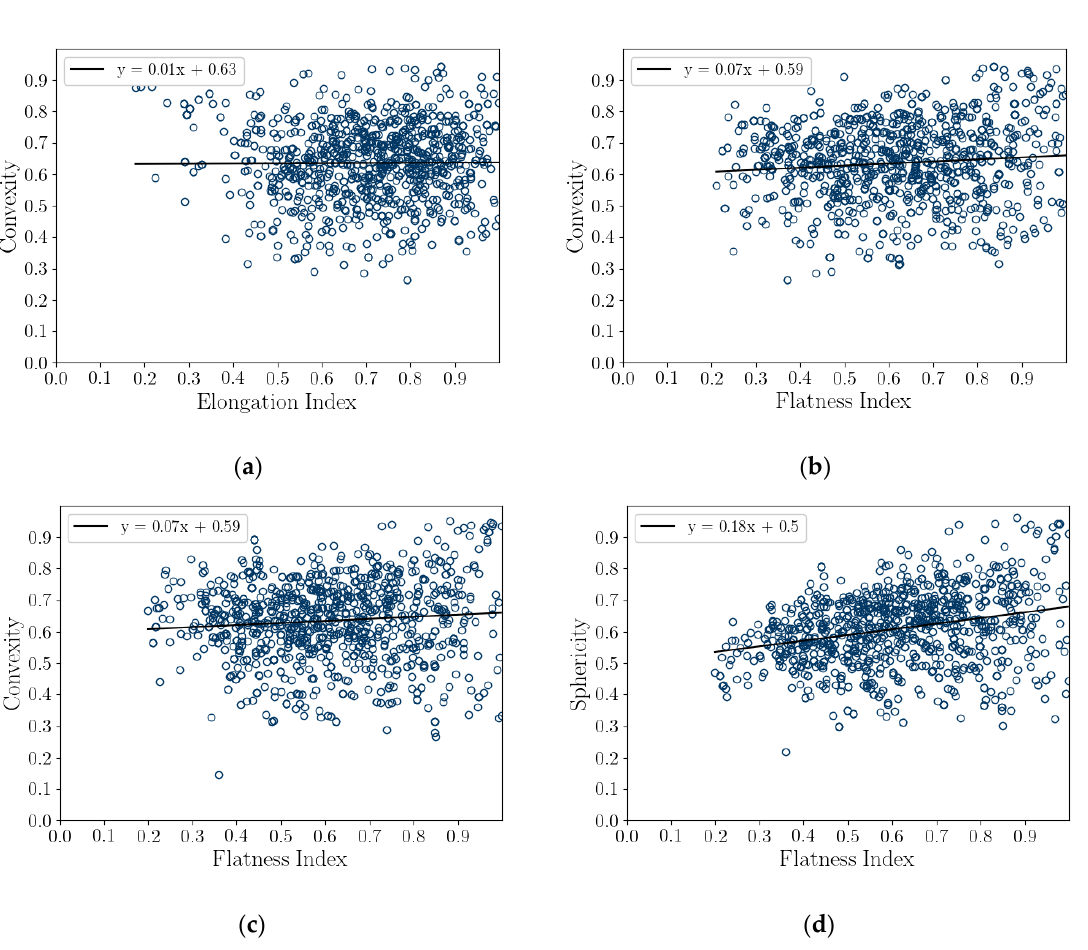
Figure 8. Correlation plots of 2D DIA and 3D μ CT aspect ratio, convexity, and sphericity for 1000 randomly selected particles. Convexity versus aspect ratio ( a ), sphericity versus aspect ratio ( b ), and sphericity versus convexity ( c ).